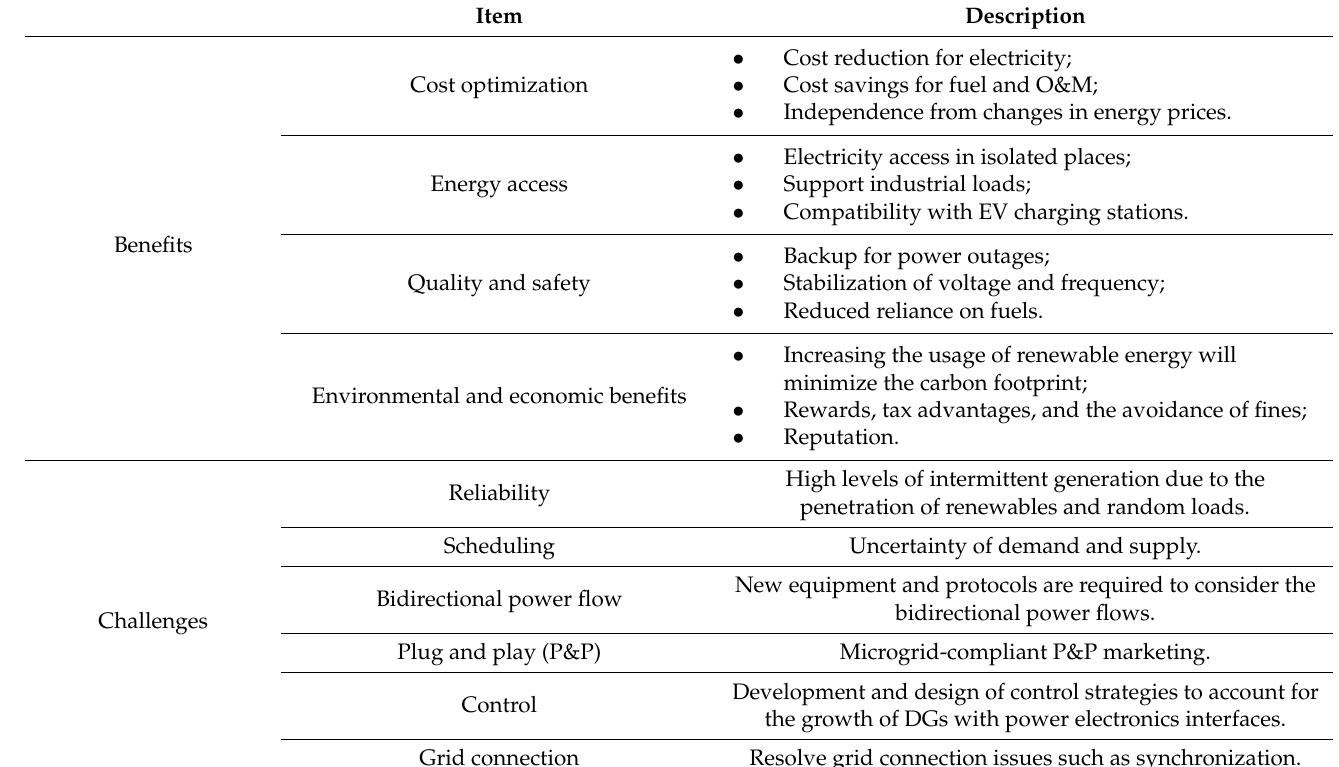
Table 1. Microgrid benefits and